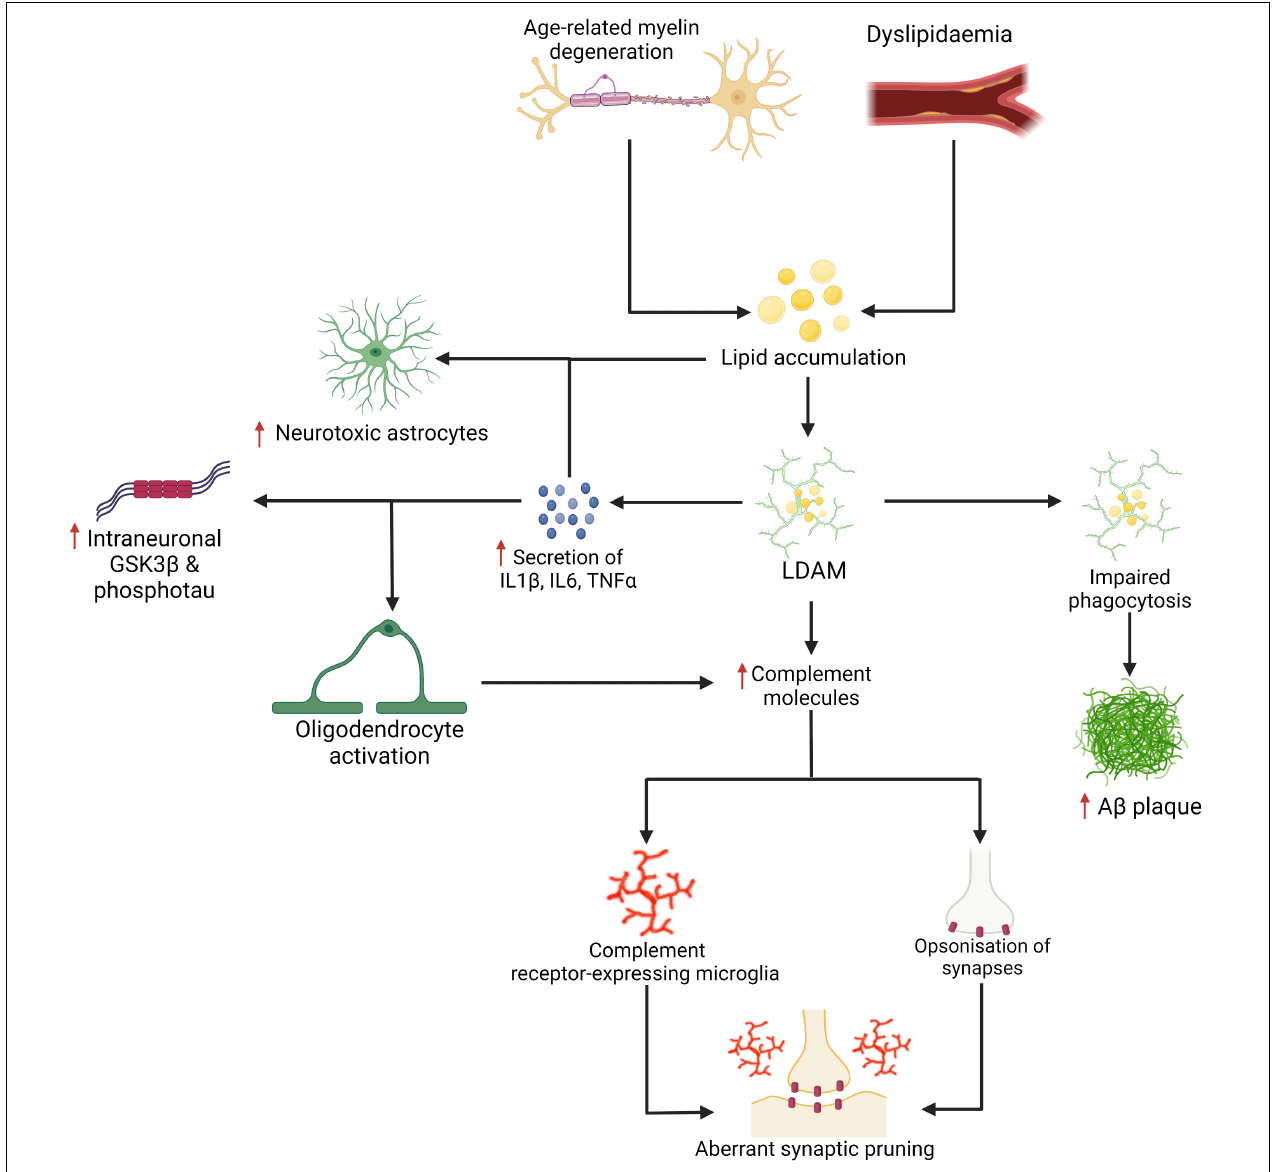
FIGURE 3 | Age-related myelin degeneration and dyslipidemia represent two risk factors for the accumulation of saturated fats and other lipids in the brain. These lipids may be internalised by microglia and stored as cholesteryl esters. Lipid-droplet-accumulating microglia (LDAM) accumulate with age and are associated with increased secretion of IL1 β , IL6, TNF α , complement molecules, and show impaired maturation of phagosomes and reduced phagocytic capacity. As demonstrated in Figure 2 , the increased secretion of certain cytokines and impaired phagocytosis are linked with more severe neuropathological changes. The signalling cytokines are also implicated in the activation of oligodendrocytes (which may be a source of excess complement deposition) and the neurotoxic activation of astrocytes (for which saturated fats are a sufficient driver). Increased expression and deposition of complement proteins may represent a key event in the targeting of synapses by microglia in AD. Created with